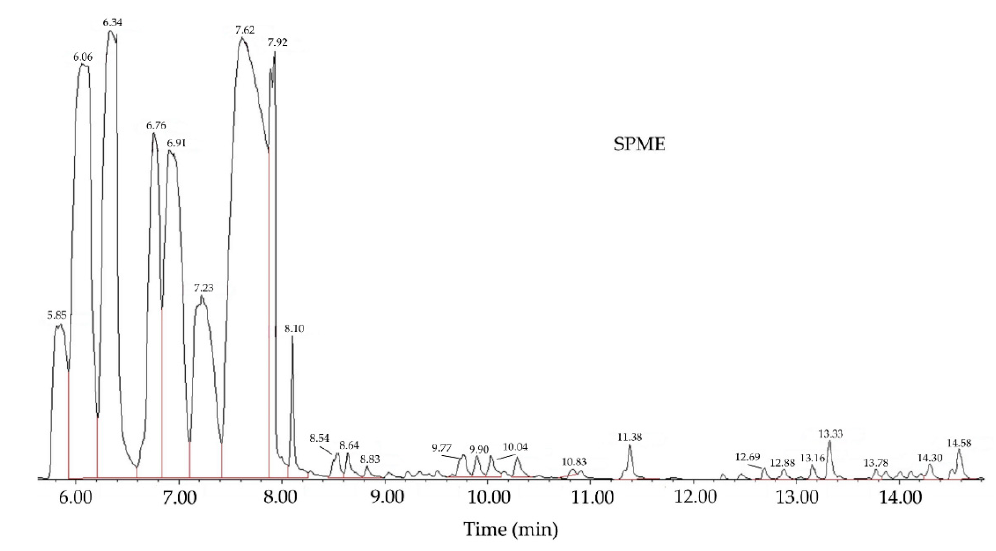
Figure 1. Chromatogram of Schinus molle essential oil obtained by HS-SPME/GC-MS.